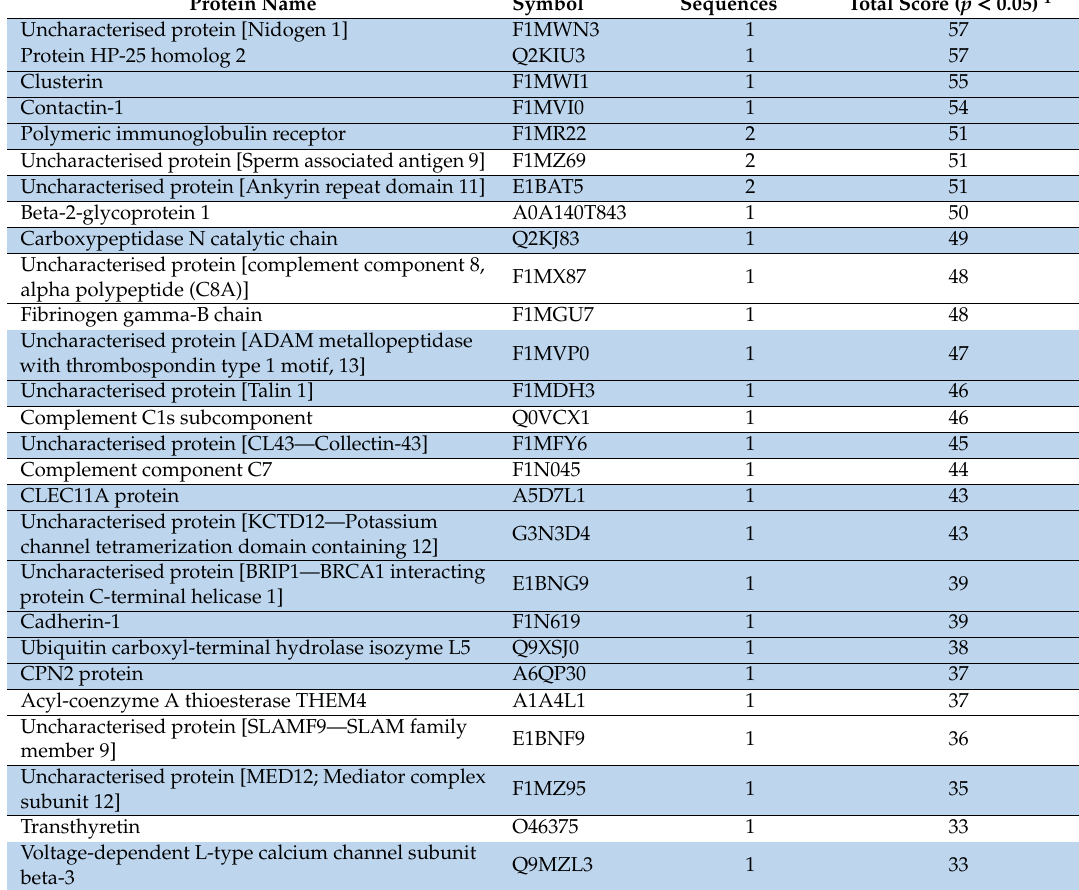
Table 2. Deiminated proteins in serum-EVs of cow ( Bos taurus ) as identified by F95-enrichment. Deiminated proteins from serum-EVs were isolated by immunoprecipitation using the